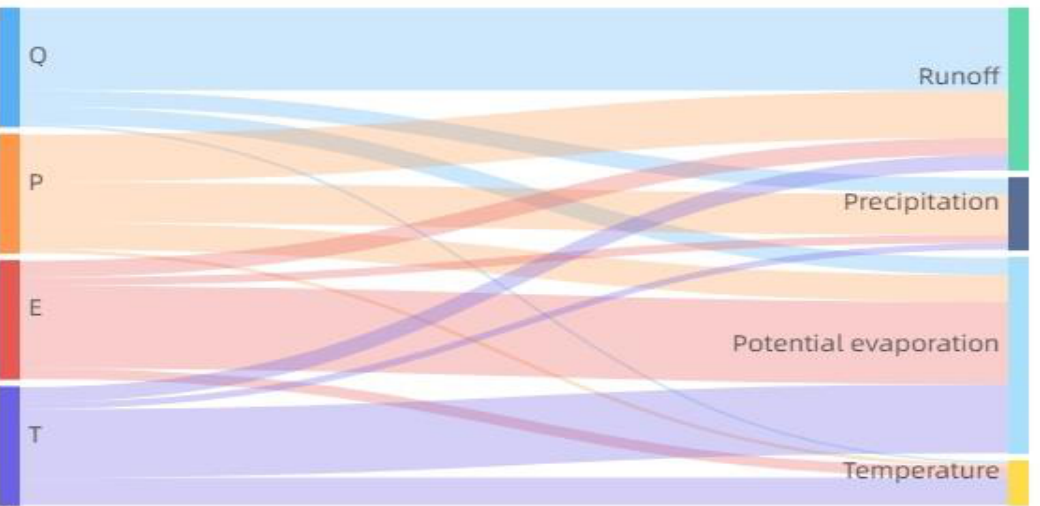
Figure 10. Mutual contribution rate of the four groups of hydro-meteorological factors.